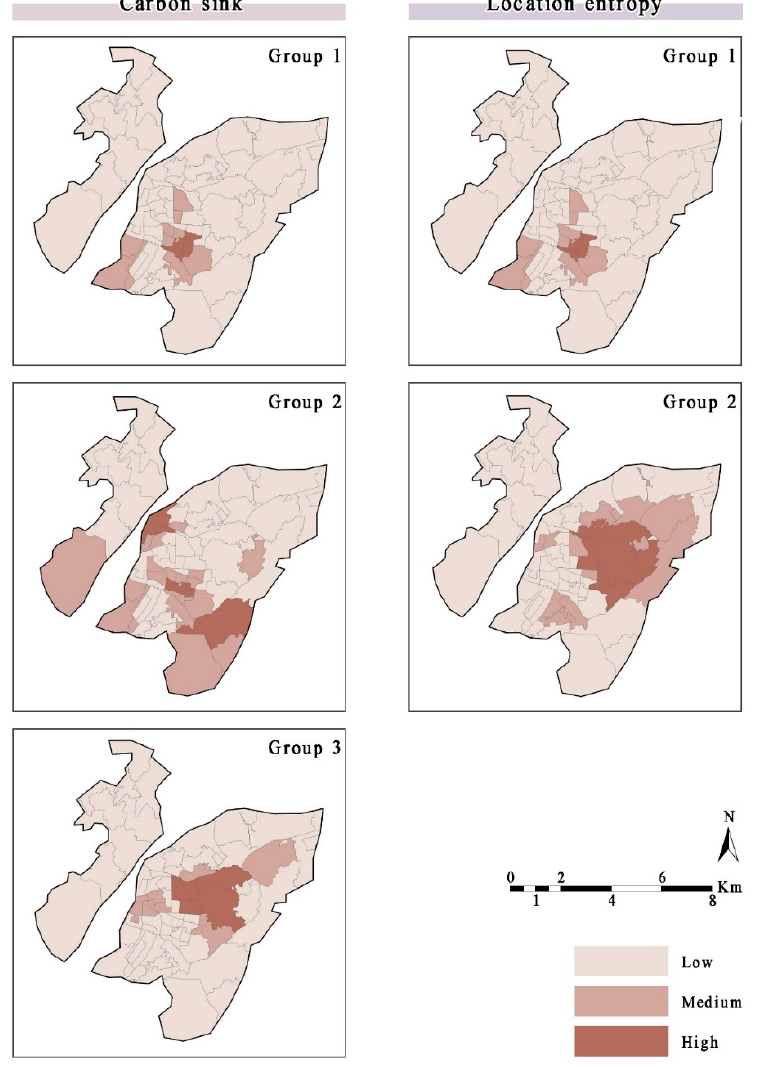
Figure 3. Spatial distribution of carbon sink performance in aggregated green